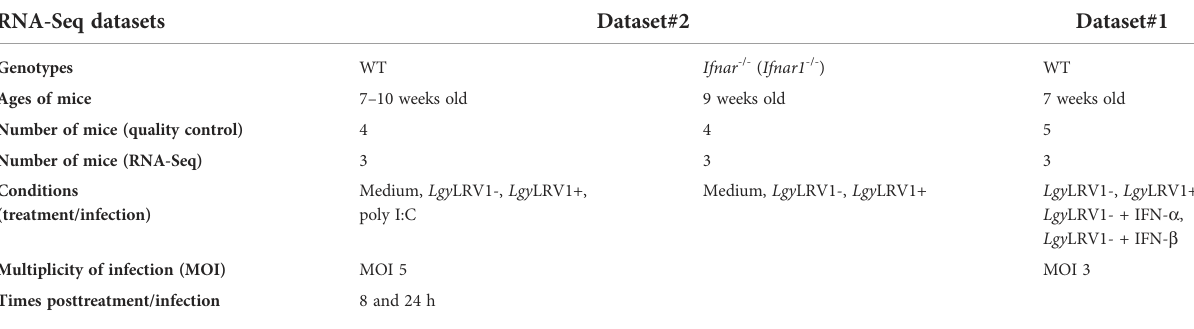
TABLE 1 Summary table of RNA sequencing samples used for the analysis.